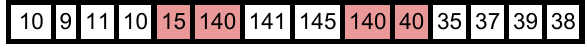
Table 1. Sample data